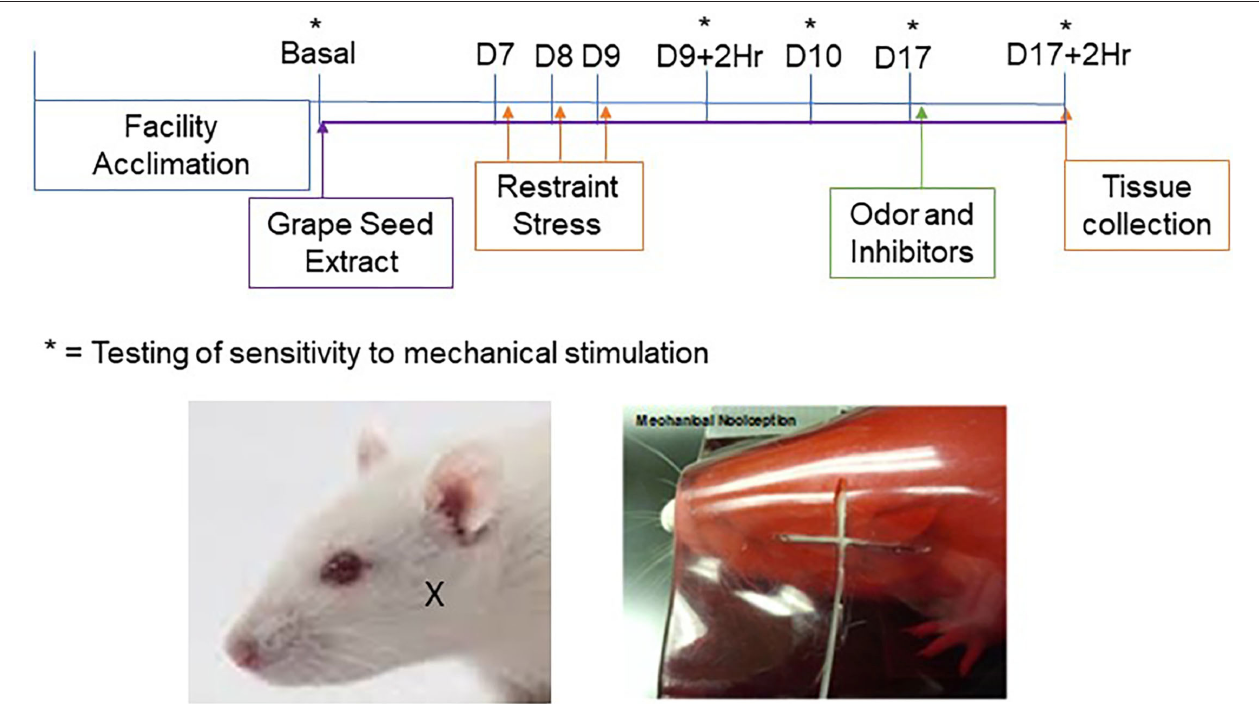
FIGURE 1 | Timeline and experimental design. Dietary supplementation of GSE was initiated one week prior to restraint stress and was continued for the duration of the study. Restraint stress was performed on 3 consecutive days (D7–9) prior to injection of cannabinoid receptor inhibitors and exposure to pungent odor on day 17. Behavioral von Frey assessments were conducted on day 0 (Basal), on day 9 two hours (D9 + 2Hr) and 24h (D10) after restraint stress, on day 17 prior to injection of inhibitors and/or odor exposure (D17), and at 2h post exposure to the pungent odor. Tissues used for immunohistochemistry were collected after the final behavioral assessment. The location of von Frey testing in the cutaneous region over the masseter muscle is shown in the images of a rat outside the holding device ( left panel ; X marking) and a rat within the device ( right panel ; filament